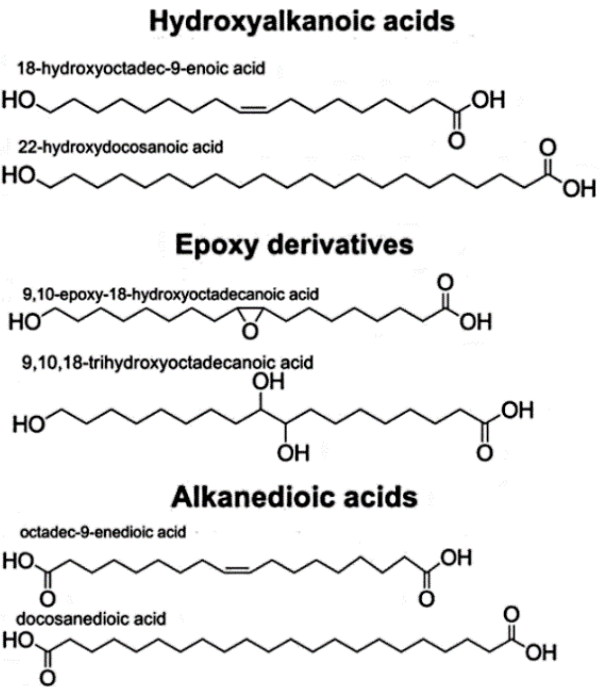
Figure 3. Structures of suberin co-monomers (Reprinted with permission from Ref. [36]. Copyright 2008, John Wiley & Sons Publishing, Wiley-VCH Verlag GmbH & Co. KGaA, Weinheim,